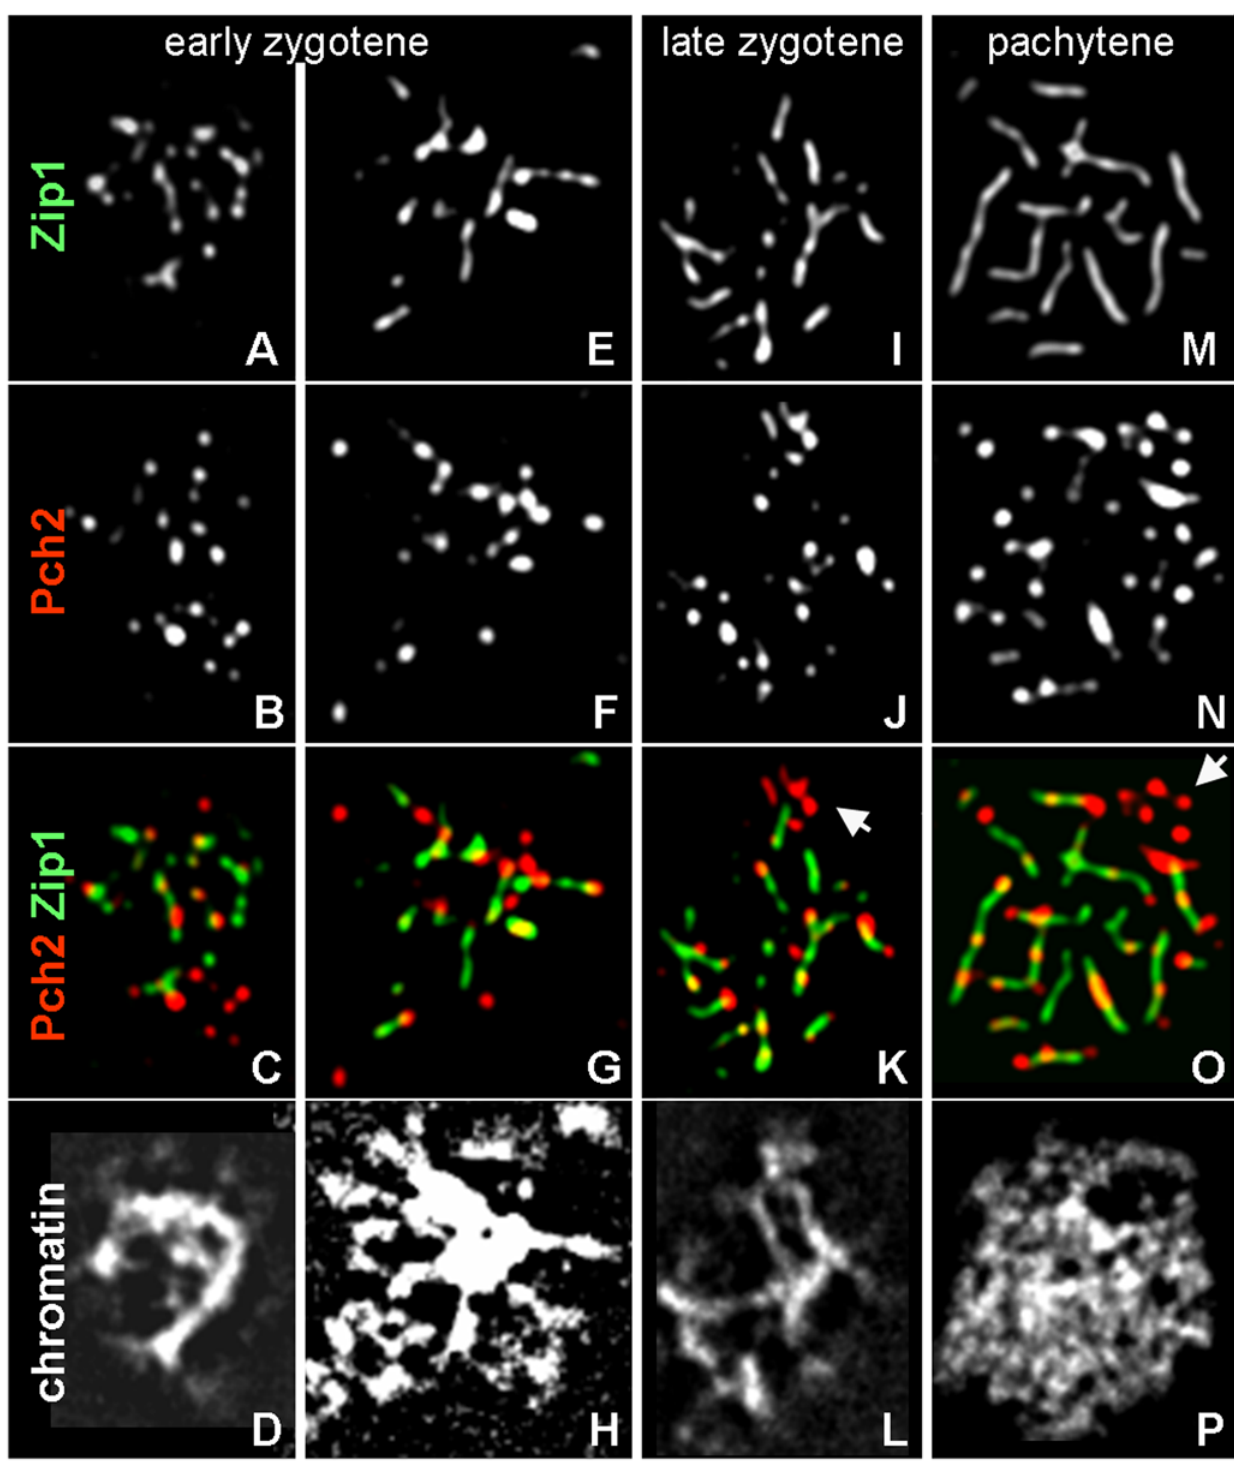
Figure 1. Association of Pch2 with WT chromosomes at different stages of SC polymerization. (A–H) Early zygotene nuclei; Zip1 (A,E), and HA-Pch2 (B,F). (I–L) Late zygotene nucleus. (M–P) Pachytene nucleus. Arrows indicate rDNA clusters, identified by Pch2 localization pattern and lack of Zip1 (K,O). Spread zygotene and pachytene nuclei are identified base on extend of Zip1 staining. Colors are indicated by the corresponding labels. Meiosis was induced at 33 u